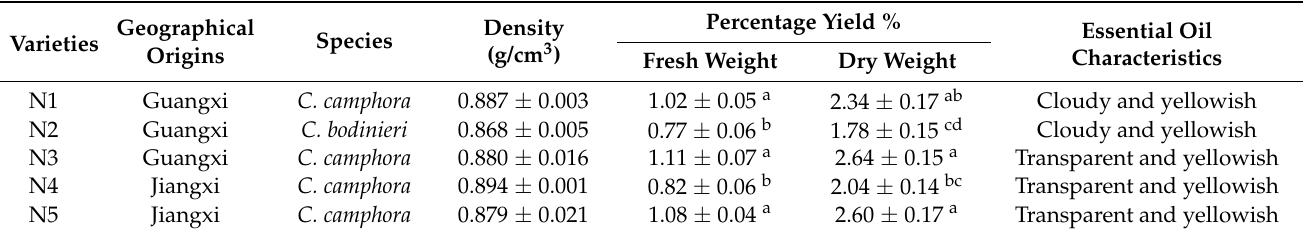
Table 1. The essential oil yield and characteristics of citral chemotype C. camphora and C. bodinieri